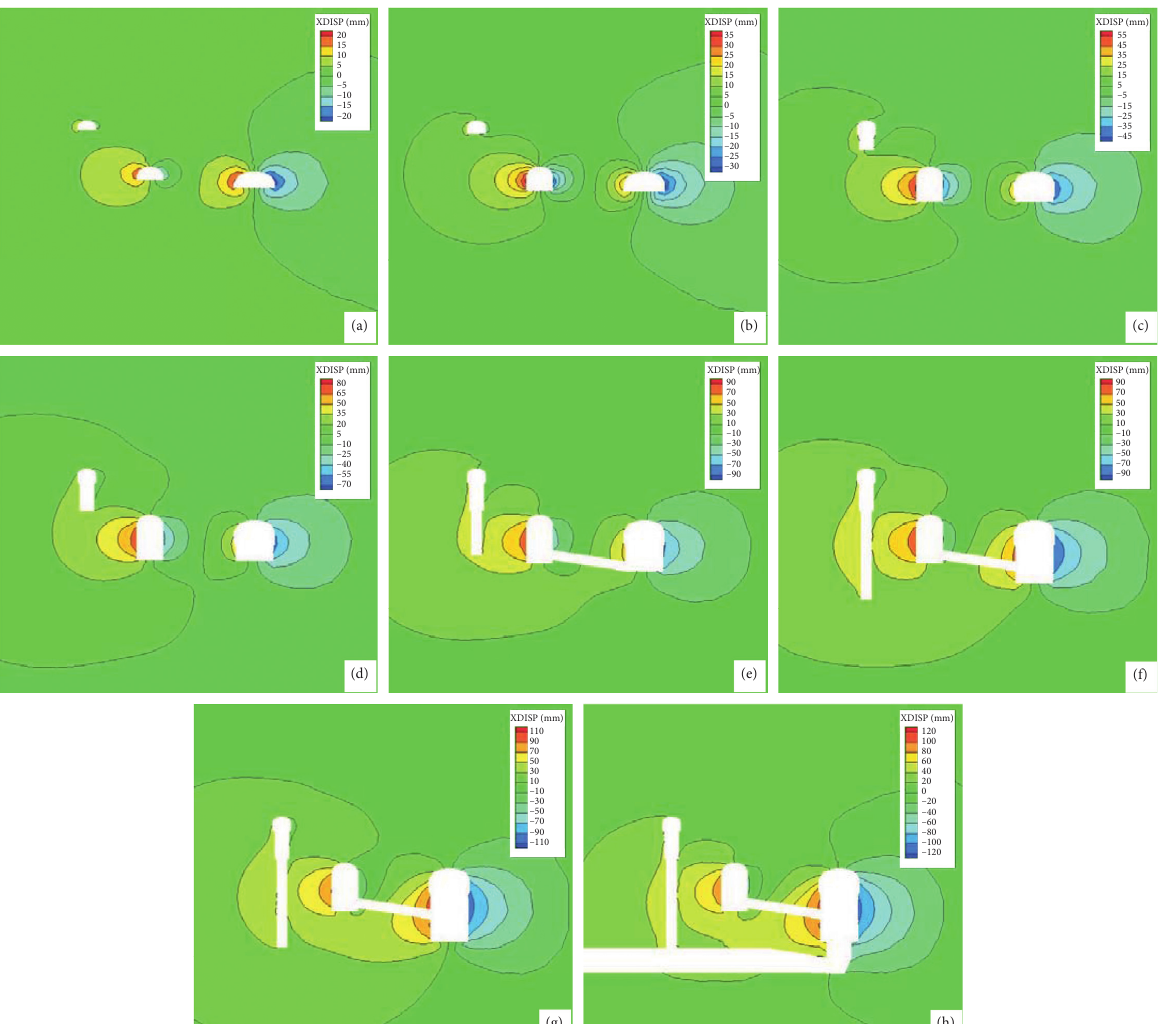
Figure 6: The horizontal displacement distribution of the surrounding rock mass at the unit 2 # section at each excavation step of the Baihetan underground